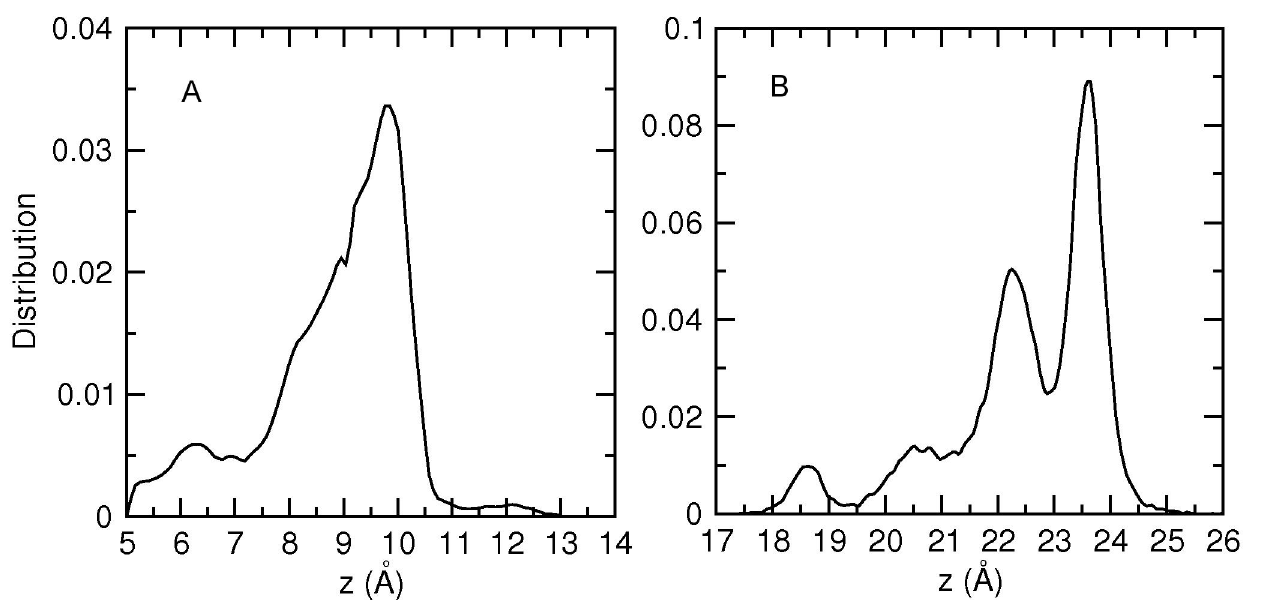
Fig 5. Distribution of the Na + ions in the pore. A) Distribution of the z -coordinate of the Na + ion in the SF obtained from a 50 ns MD simulation. B) Distribution of the z -coordinates of Na + ions in the vestibule obtained from a 125 ns MD simulation.